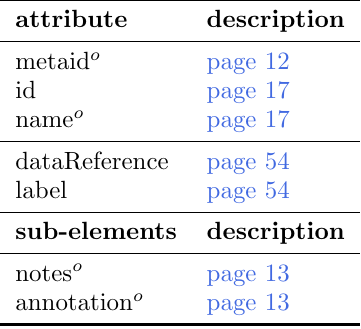
Table 2.27: Attributes and nested elements for dataSet. o denotes optional elements and attributes.